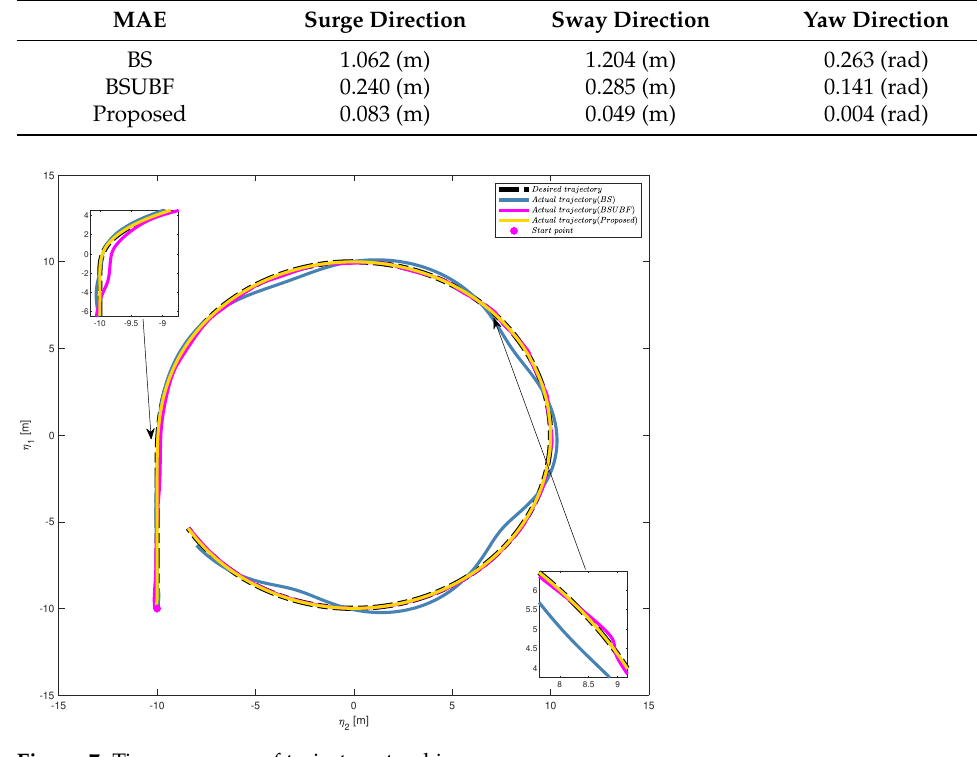
Figure 7. Time response of trajectory tracking.